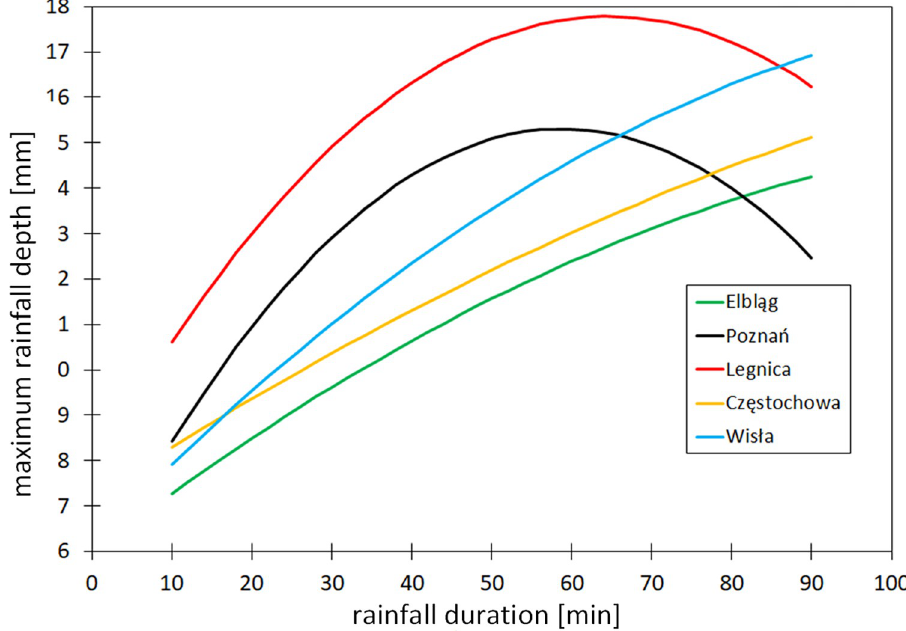
Fig 3. Mean high of convective rainfall depths as a function of their duration at selected meteorological stations (names in Fig 1) located in different regions of Poland.